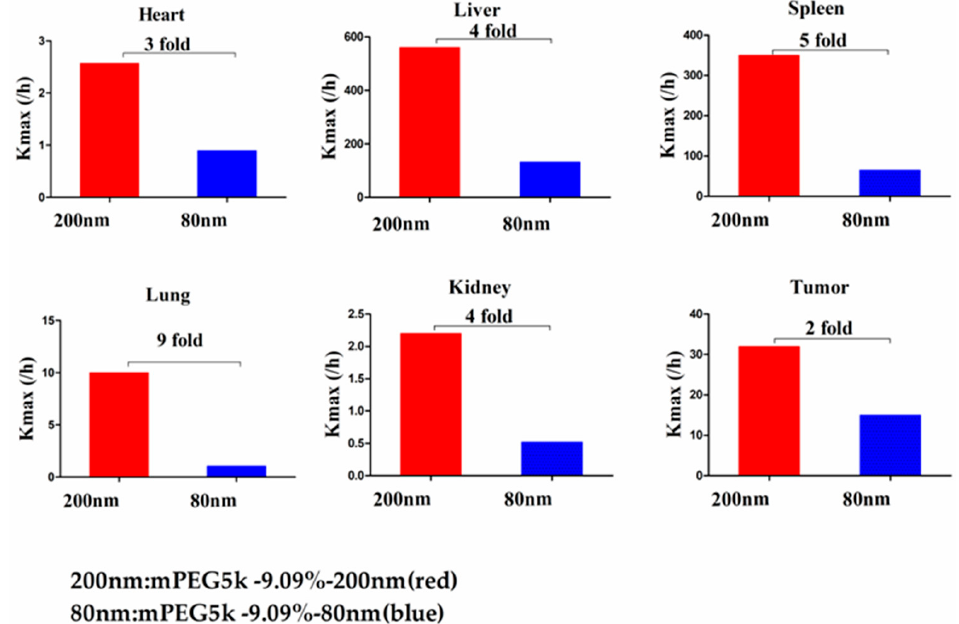
Figure 12. K max (/h) for mPEG5k-9.09%-200 nm (red) and mPEG5k-9.09%-80 nm NPs (blue).